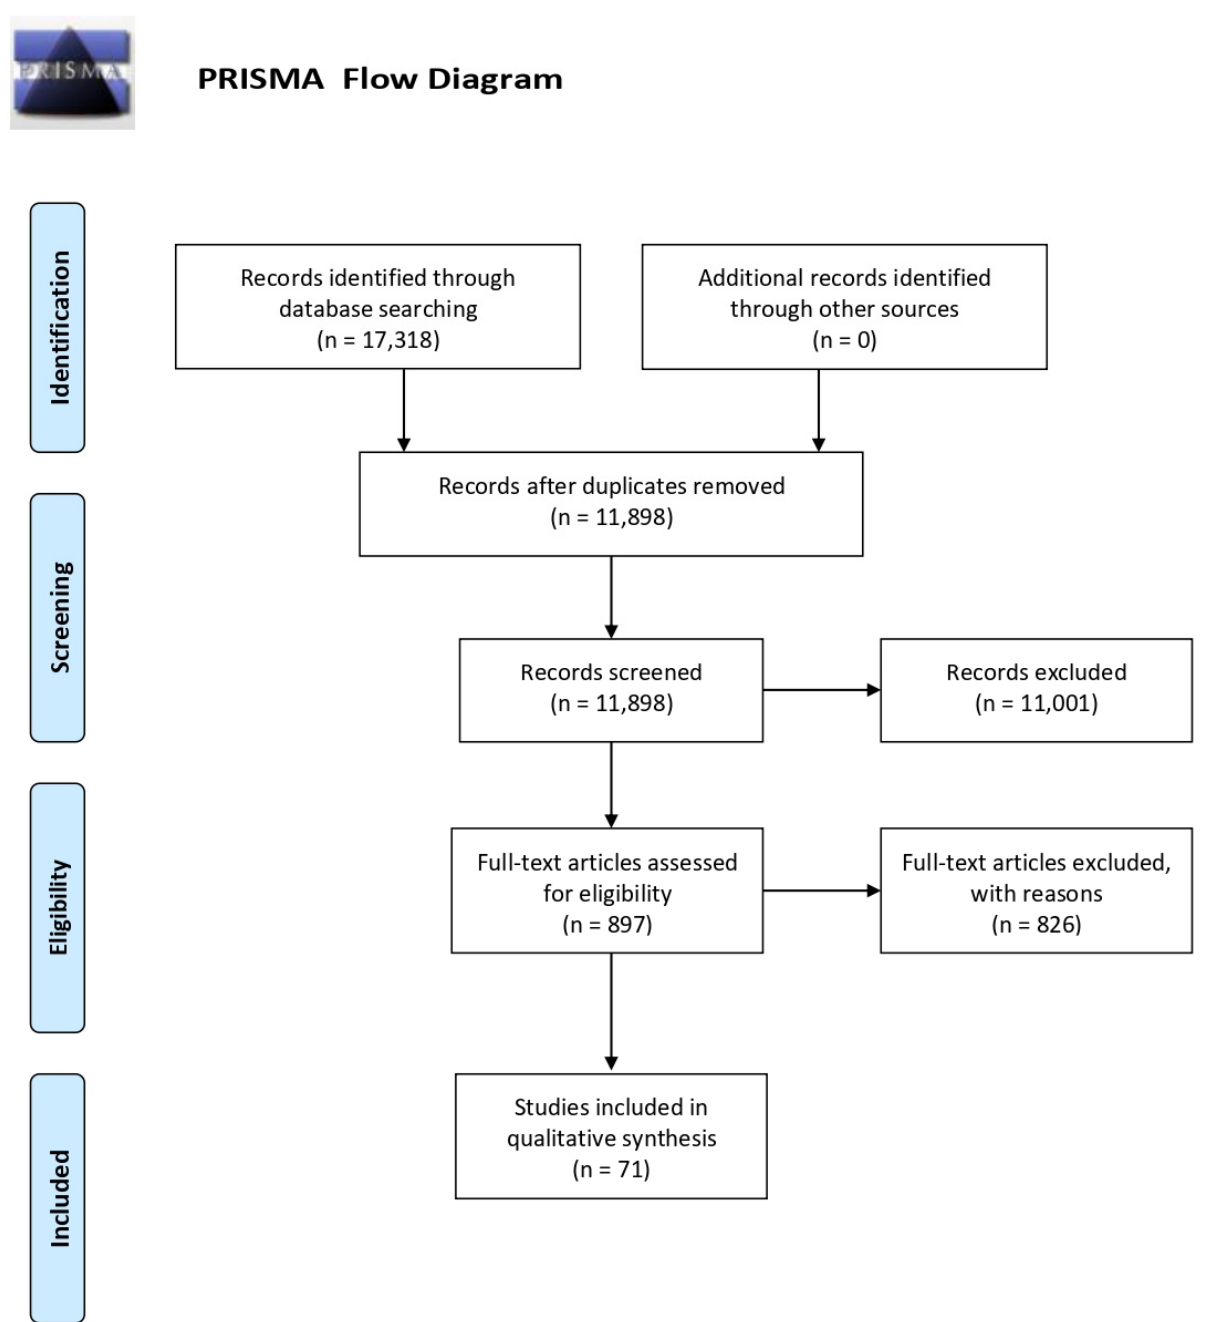
Figure 1. PRISMA flow diagram.